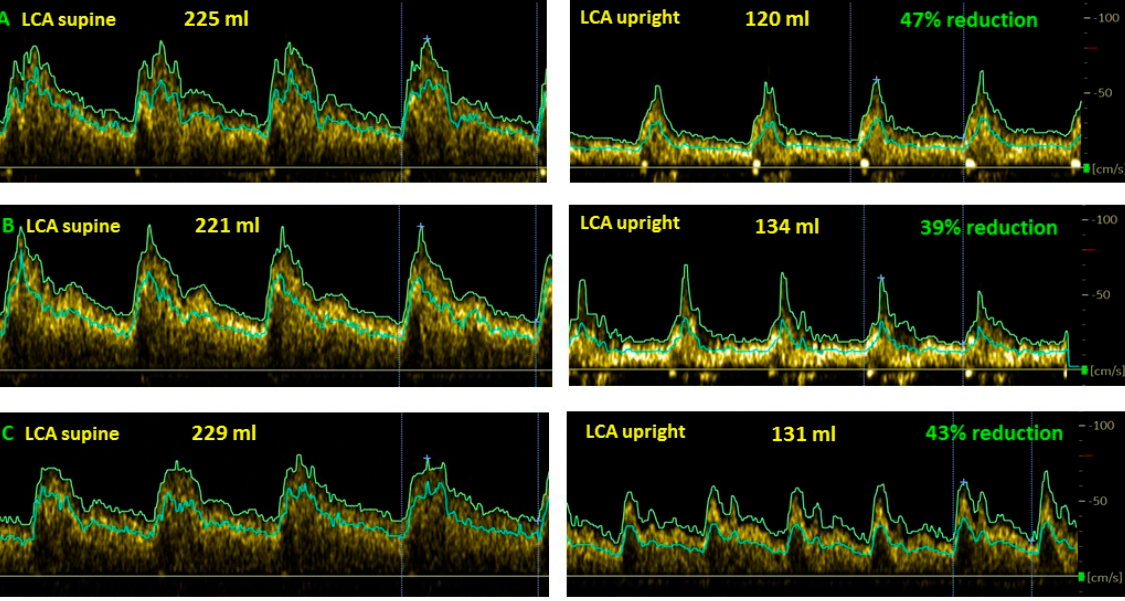
Figure 3. Examples of cerebral blood flow decrease while upright compared to supine in long-haul COVID patients. ( A ): female, 37 years old; ( B ): female, 35 years; ( C ): female, 24 years, LCA: left carotid artery.